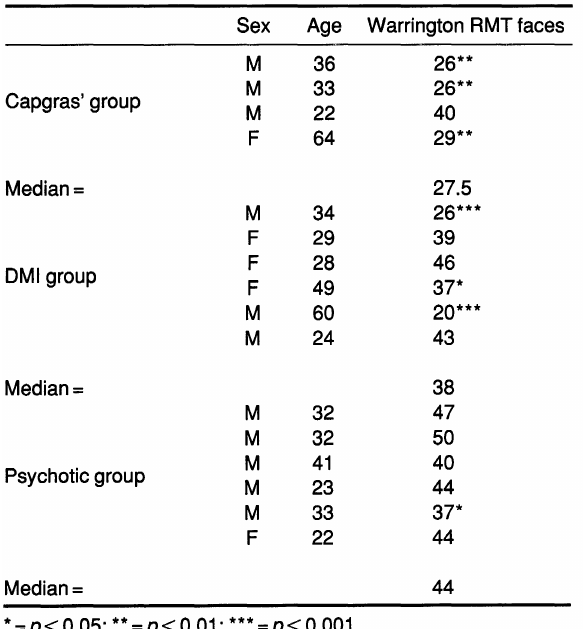
TABLE II. Scores on the Warrington Recognition Memory Test for faces for Greek patients classified as Capgras' type, mixed-DMI and psychotic